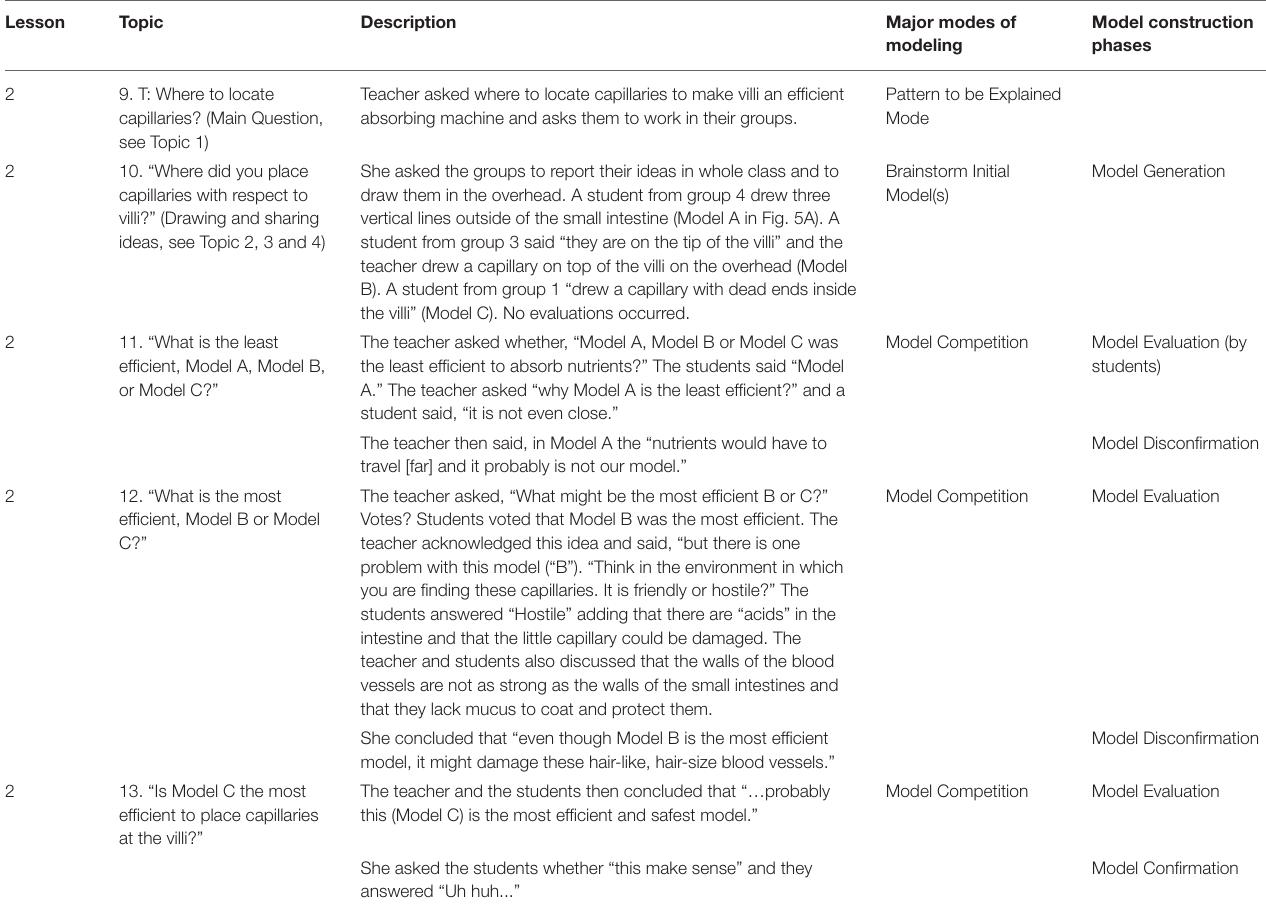
TABLE 5 | A new round of modeling (part 3). Lesson